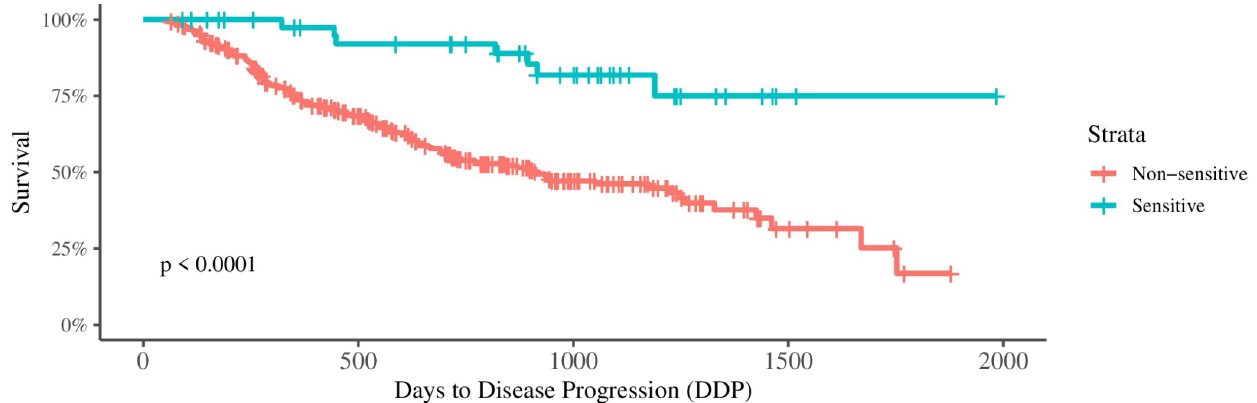
Fig 2. Observed survival grouped by TS classes according to days to disease progression with death events.